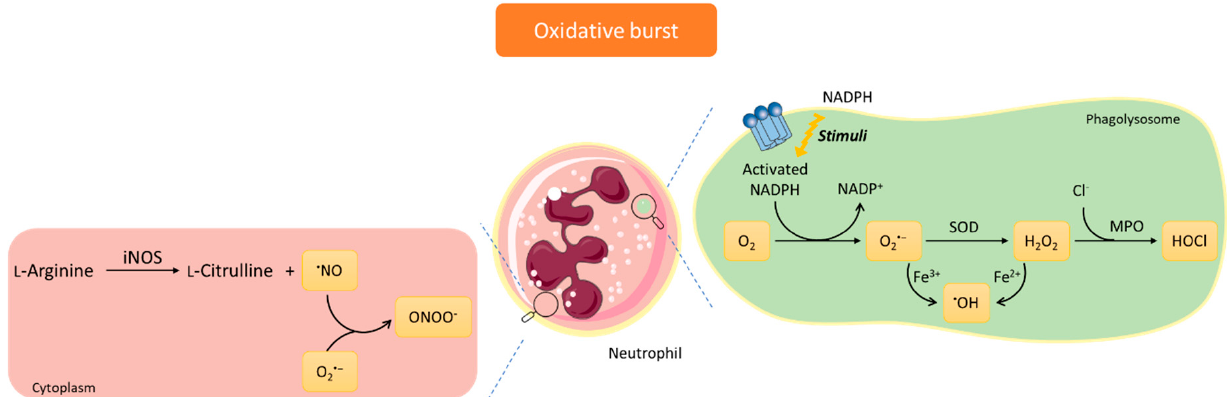
Figure 1. Mechanisms involved in production of reactive species in neutrophils’ oxidative burst. The nicotinamide adenine dinucleotide phosphate (NADPH) oxidase complex is activated, its cytoplasmic components migrate to the cellular membrane, and the molecular oxygen is reduced to the superoxide anion radical (O 2• − ), which in turn is the precursor to hydrogen peroxide (H 2 O 2 ) and other reactive species [3,4,7,8]. Most of the H 2 O 2 formed is consumed by myeloperoxidase (MPO), which catalyzes the formation of hypochlorous acid (HOCl), in the presence of H 2 O 2 and by oxida- tion of the halide Cl - , since this ion exists in high concentrations in the body [4,7–9]. In the cytoplasm,